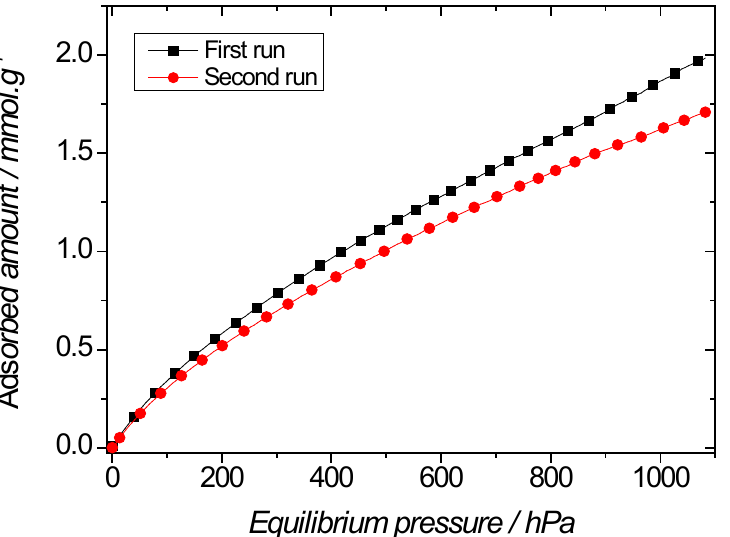
Figure 18. CO 2 sorption isotherms by iPrbipy PMO 6 at 273 K. (Squares) first sorption isotherm; (Circles) second sorption isotherm after reactivation at 60 °C for 2 h under secondary vacuum.